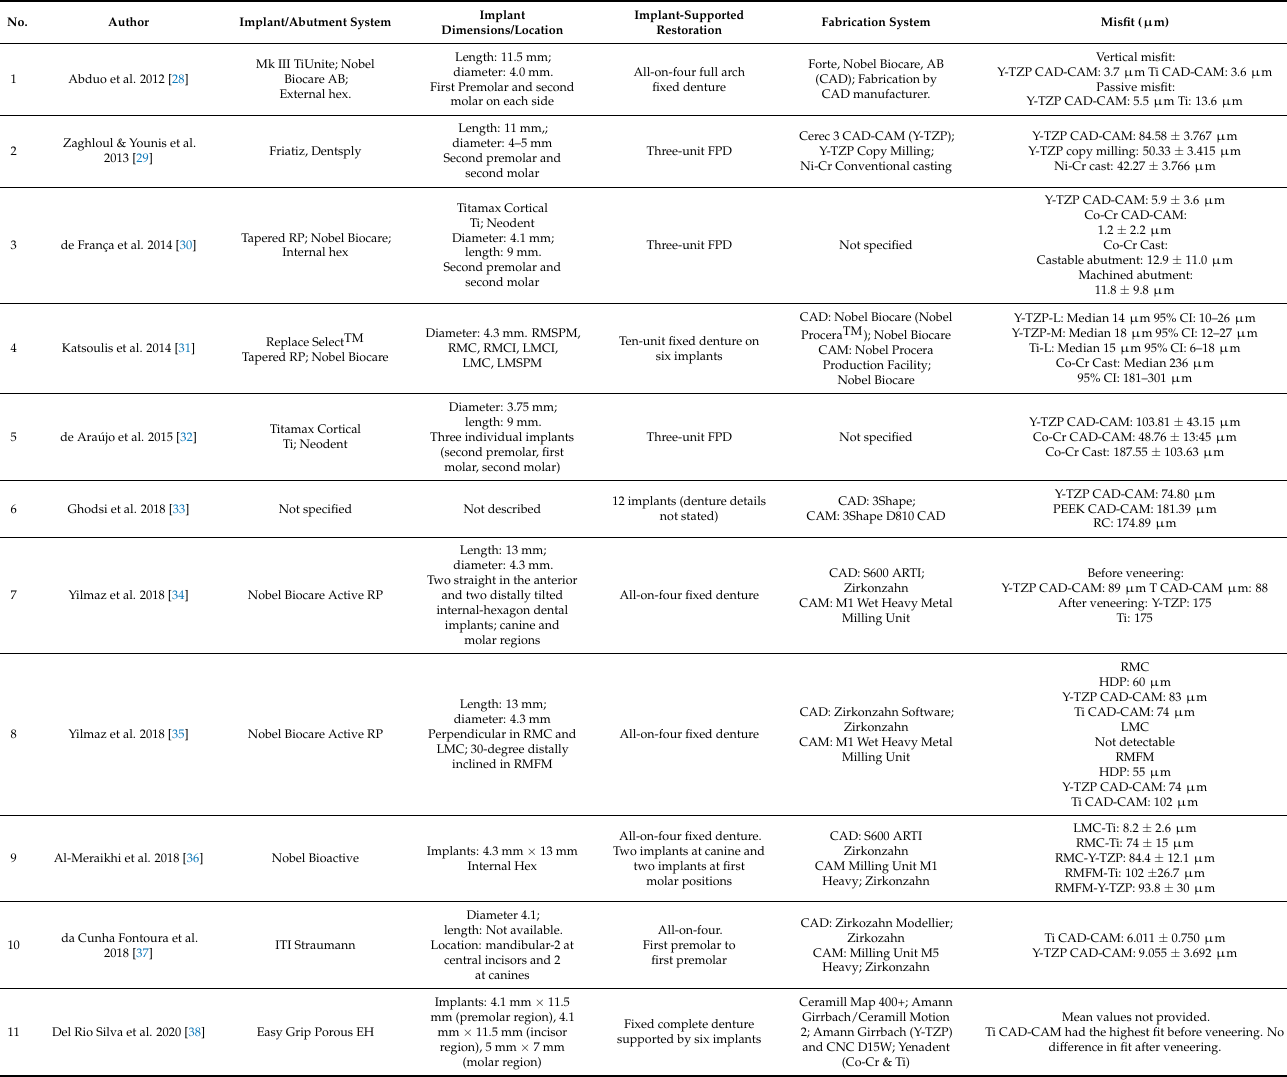
Table 2. Implant-related characteristics and misfit values in the included